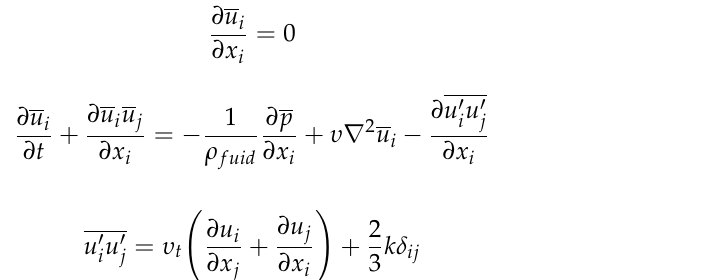
Figure 3. Schematic of the two-dimensional model.